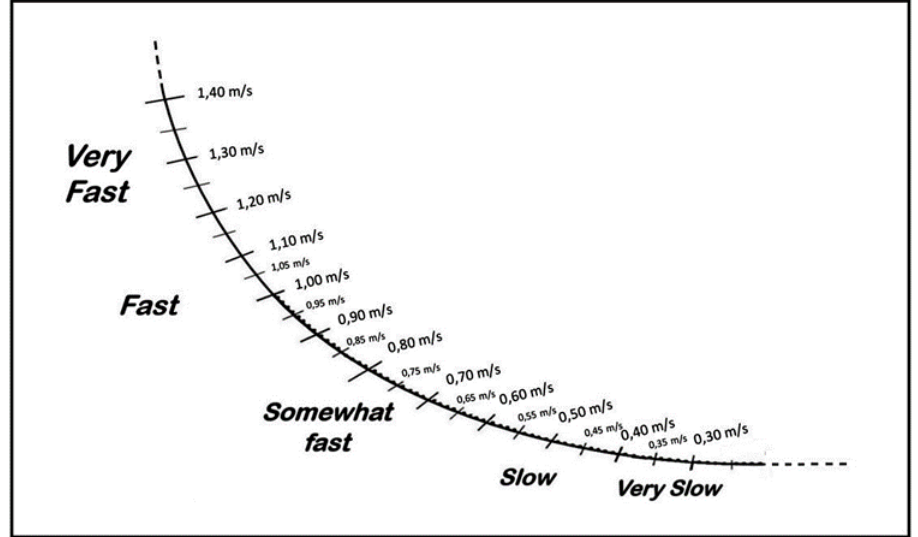
Figure 1. Perception Velocity Scale for